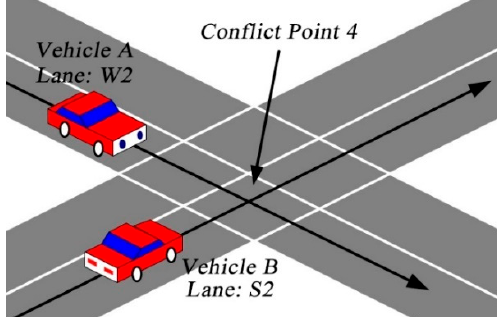
Figure 5. Diagram of a potential collision accident.